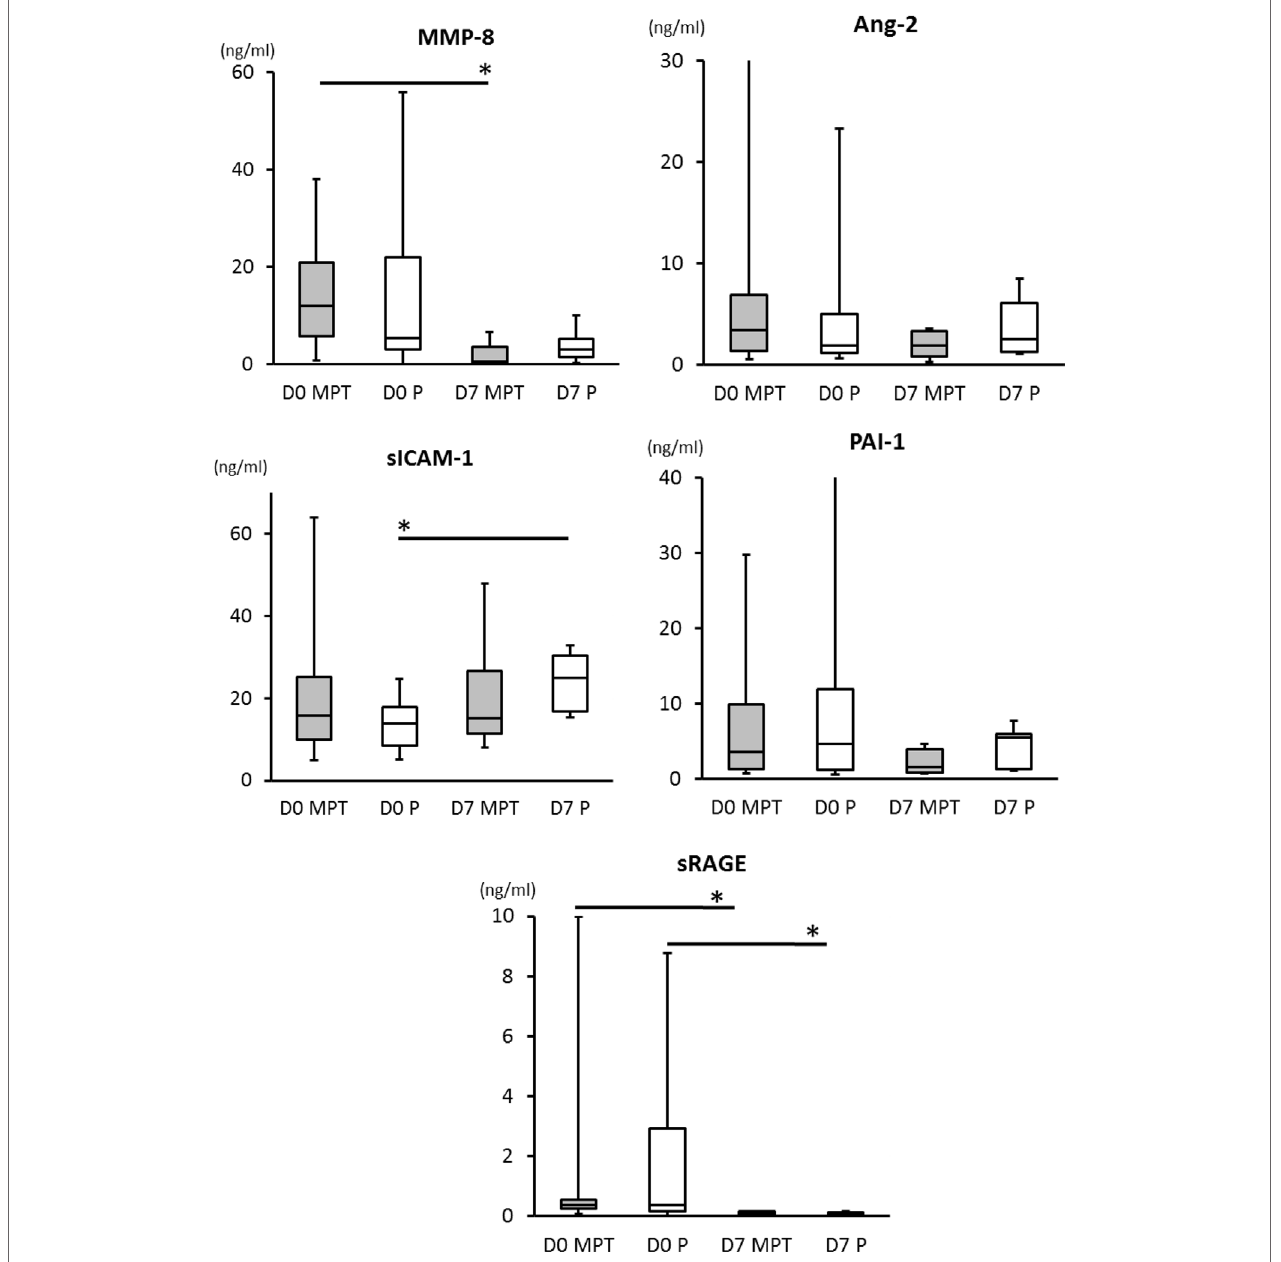
FiGUrE 1 | comparisons of biomarker levels between placebo and the MPt groups on days 0 and 7 . There are no differences between cytokine levels detected in MPT and control groups on day 0 or day 7. Two-tailed unpaired t or u test dependent were used dependent upon variances differences evaluated by F test. On day 7, we observed a significant reduction in plasma levels of MMP-8 ( p = 0.0016) in the MPT and a significant increase in plasma levels of sICAM-1 ( p = 0.0005) in the placebo group (MPT group had no increase by day 7). Levels of sRAGE decreased significantly in both the MPT and placebo groups ( p < 0.002) from day 0 to day 7. A p -value of < 0.05 was considered significant